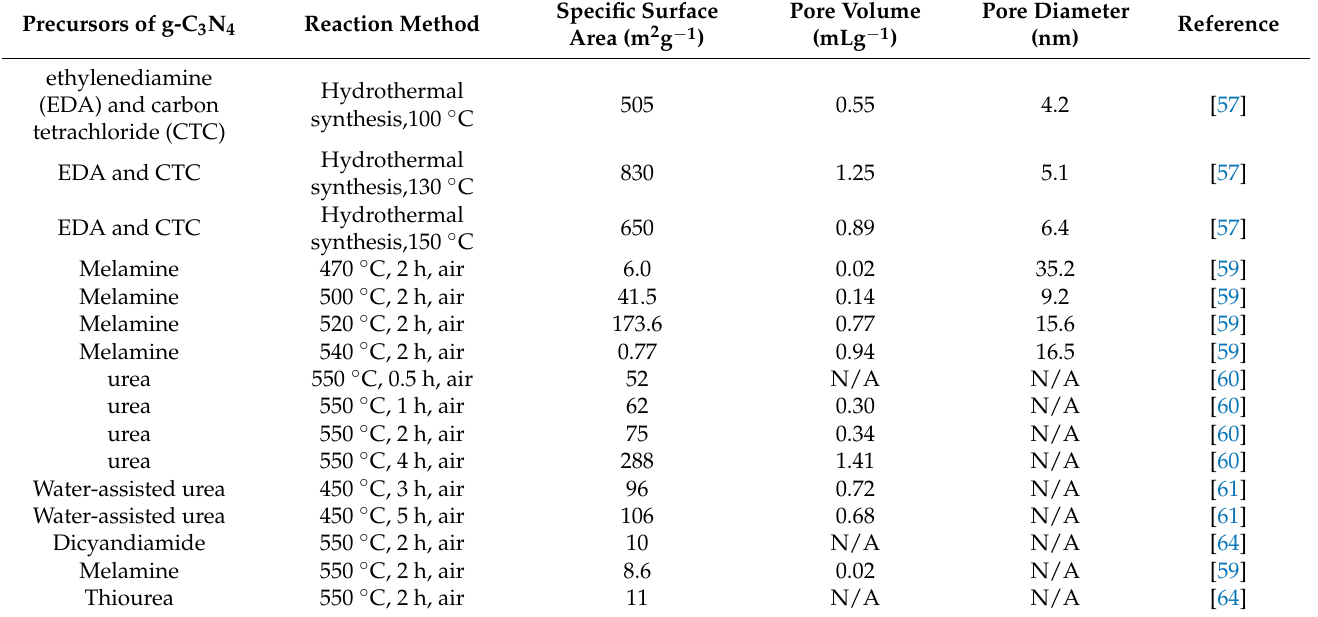
Table 2. Specific surface area, pore volume, and pore size of g-C 3 N 4 under different precursor types and different synthesis